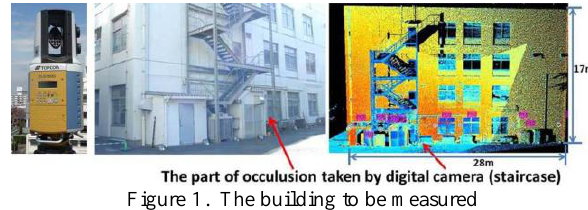
Figure 1. The building to be measured Left: Laser Scanner, Middle: Photograph, Right: Point-cloud